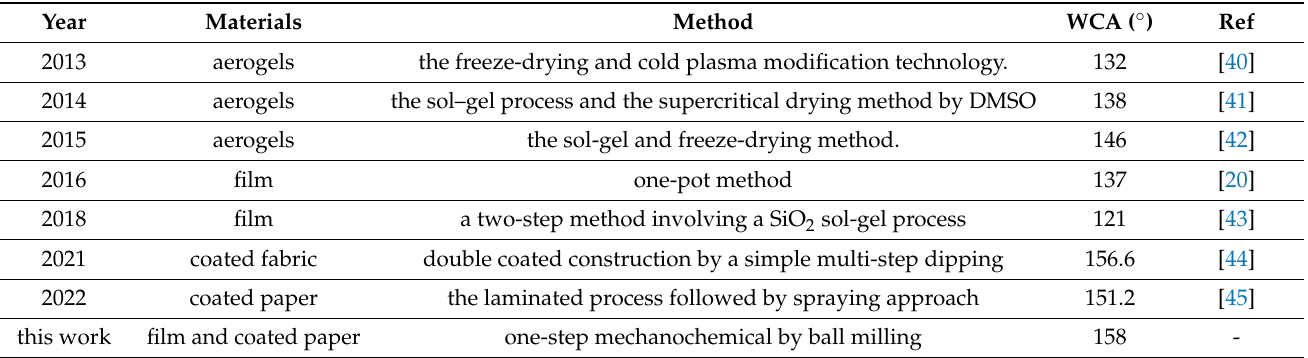
Table 2. Comparison of hydrophobic SiO 2 and cellulose-based composite in recent literatures.